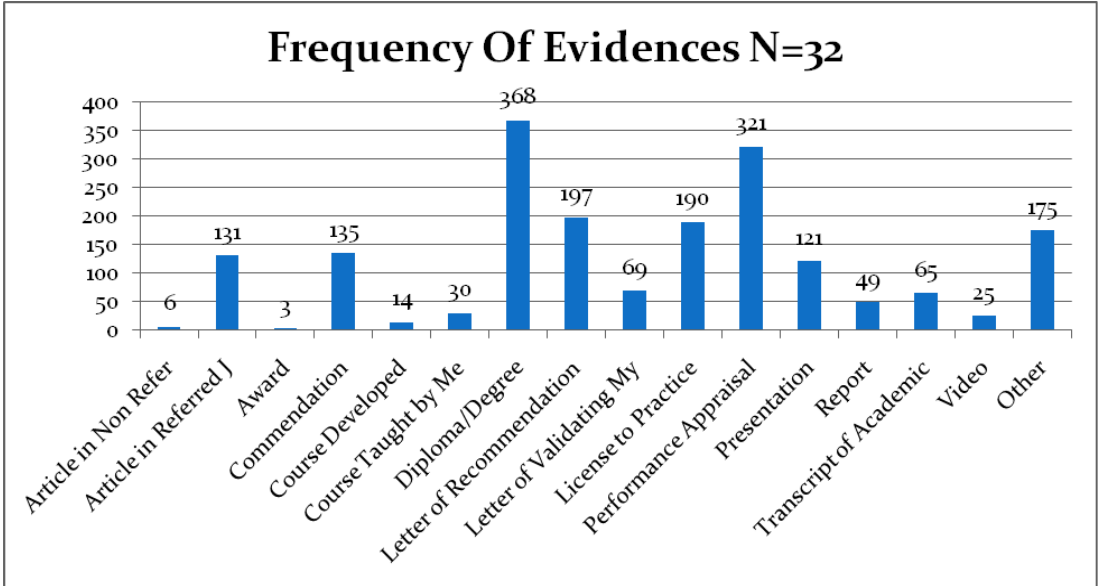
Figure 1 . Frequency of evidences to support degree equivalence across 104 competency statements.